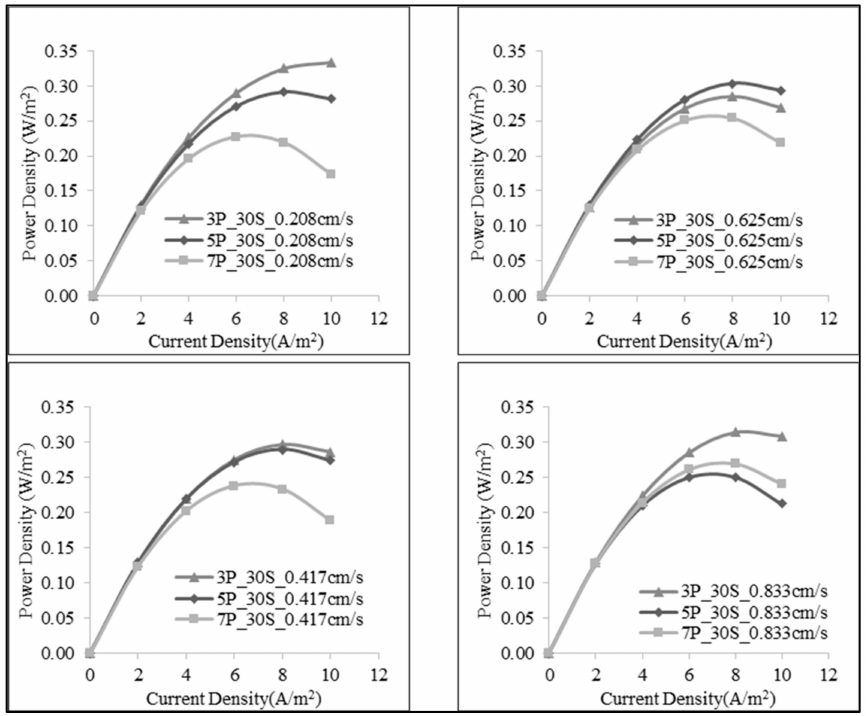
Figure 4. Effect of the number of the membrane pair on power density for the 1:30 salinity ratio. (XP_YS_Zcm/s indicates X membrane pair, Y salt content of HSS and Z feed